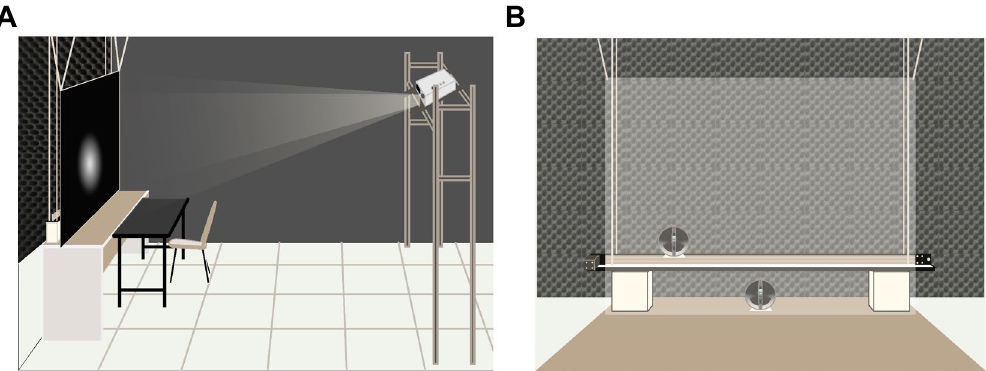
Figure 7. Experimental setup. ( A ) Side view of the experiment room. Participants sat in front of a large white screen, which was hung from the ceiling using elastic ropes. An LCD projector was mounted above and behind participants to project visual stimuli on the screen. ( B ) Front view of the experiment room. Behind the white screen (the transparency was changed for the purpose of visualization), there was a loudspeaker mounted on